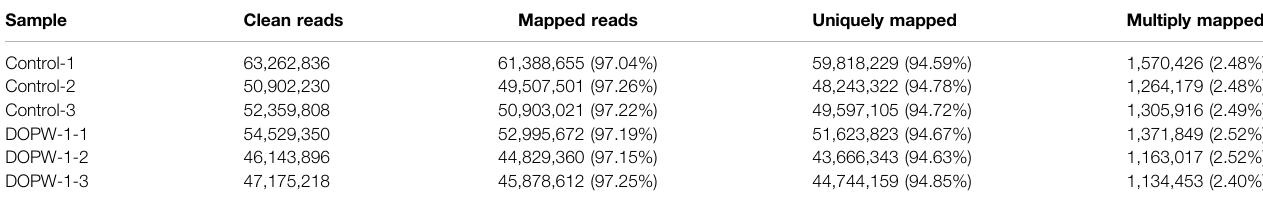
TABLE 4 | Summary of RNA-seq alignment. Sample